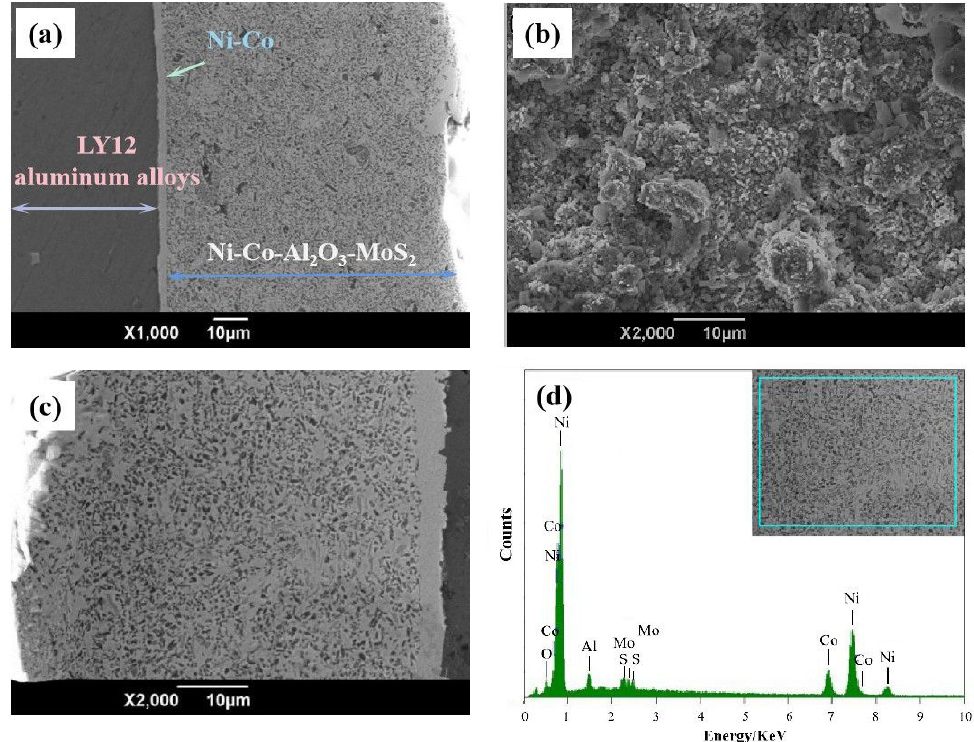
Figure 2. Composition and morphologies of as-prepared Ni-Co matrix composites.